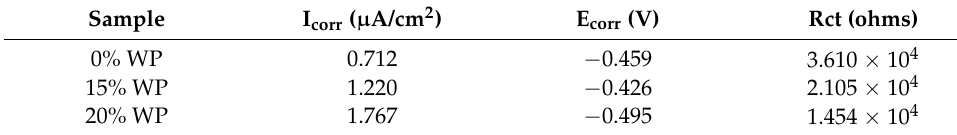
Table 4. Potentiodynamic curve (Tafel plots) parameters.